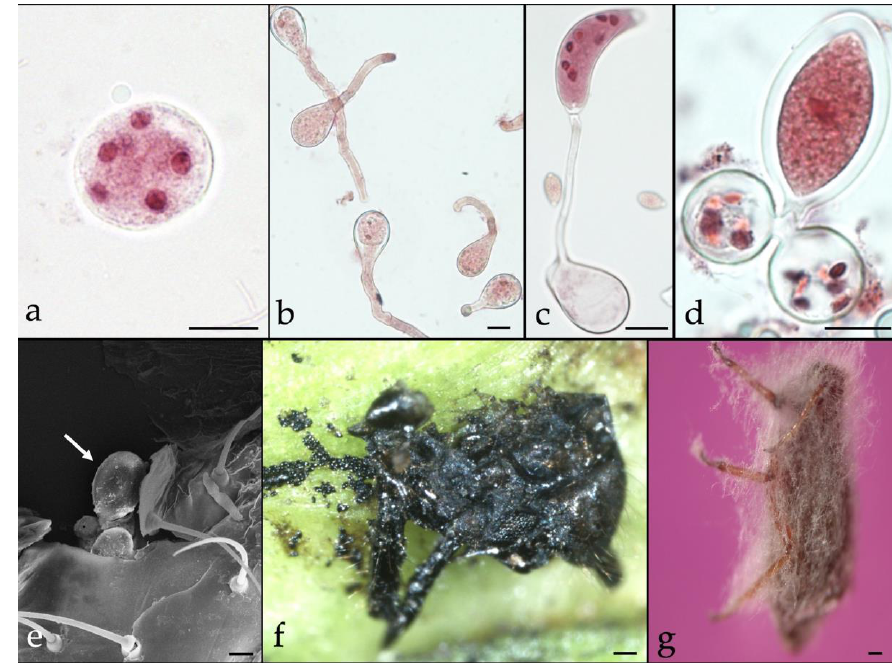
Figure 1. Entomopathogenic fungi, Neozygites osornensis ( a – f ) and Lecanicillum attenuatum ( g ). on Cinara cupressi . ( a ). Subspherical hyphal body with visible nuclei (Bar = 10 µ m), ( b ). Primary conidia germinating apically (Bar = 10 µ m), ( c ). Capilliconidium developed from primary conidium on capillary tube (Bar = 10 µ m), ( d ). Zygospore developing by conjugation of two hyphal bodies (Bar = 10 µ m), and ( e ). Fully developed zygospore attached on killed aphid (Bar = 10 µ m), ( f ). Fungus-killed C. cupressi (Bar = 100 µ m), and ( g ). Mycelial growth on fungus-killed C. cupressi (Bar = 100 µ m). Insects 2019 , 10 , x FOR PEER REVIEW